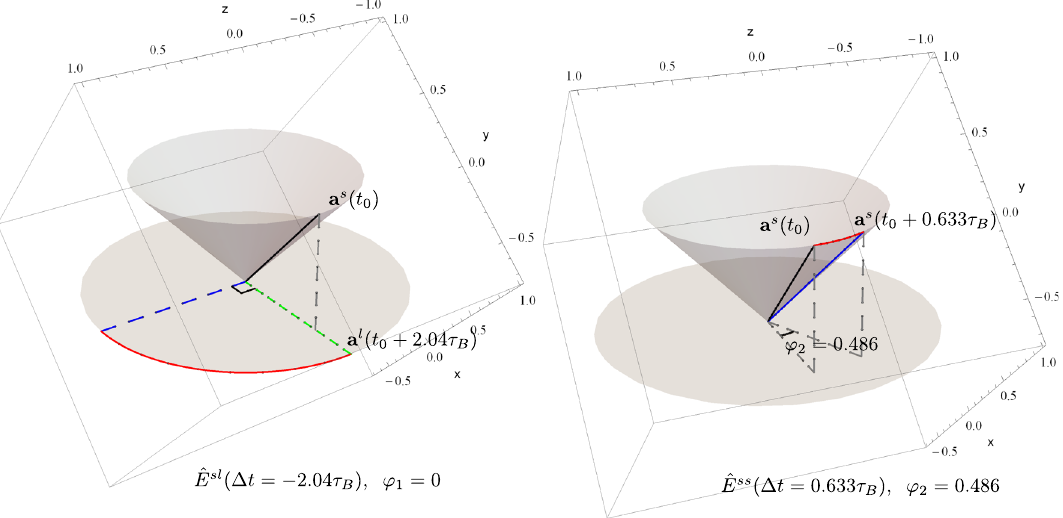
Fig. 3 The correlation functions to be measured. The left picture represents ˆ E sl ((cid:20) t = π/ 2 x (cid:4) ≈ 2 . 04 τ B ) = ˆ E sl (ϕ 1 = 0 ) . The right picture represents ˆ E ss ((cid:20) t = 0 . 486 / x (cid:4) ≈ 0 . 633 τ B ) = ˆ E ss (ϕ 2 ≈ 0 . 486 ) . They give rise to g d 1 (ϕ 1 = 0 ,ϕ 2 ≈ 0 . 486 ) , which maximally violates the second lower bound of our